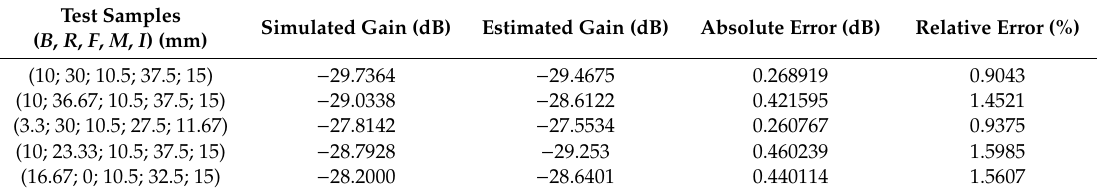
Table 4. Estimation error at random